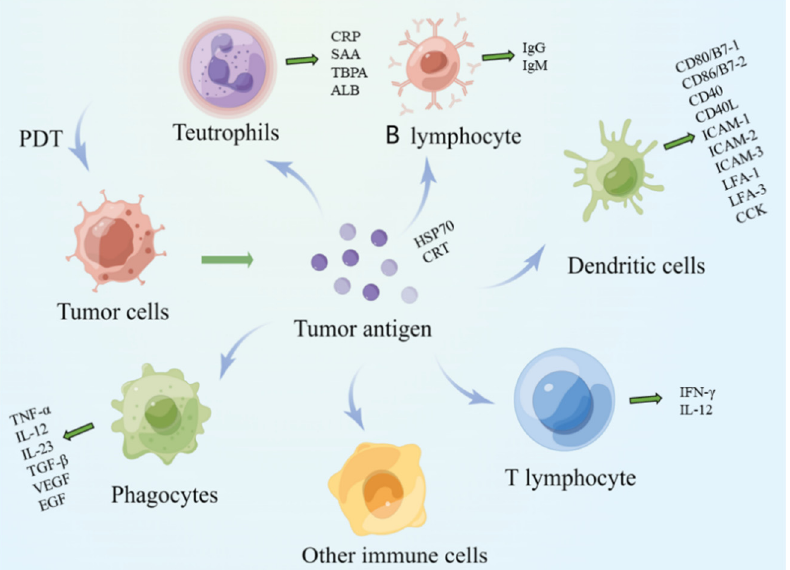
Figure 2. The process of immune response induced by tumor cells as antigens. Tumor cells produce tumor-associated antigens after PDT, which act on neutrophils, monocytes, macrophages, B cells, T cells, dendritic cells, and other immune cells. Immune cells are activated to produce cytokines to mediate the immune process in vivo.